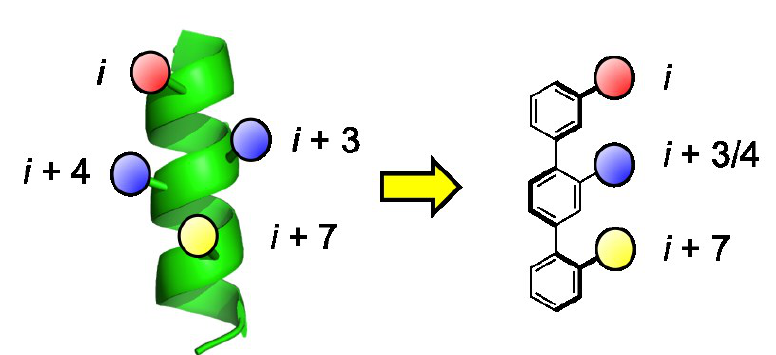
Figure 1. An α-helix ( left ) and a terphenyl-based α-helix mimetic ( right ), highlighting the amino acid side chains located on one face. Colours correspond to amino acid side chains and their respective